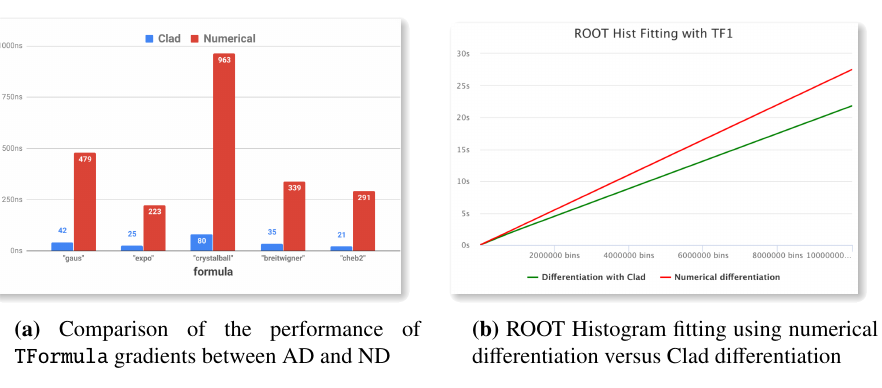
Figure 3: Performance benchmarks in